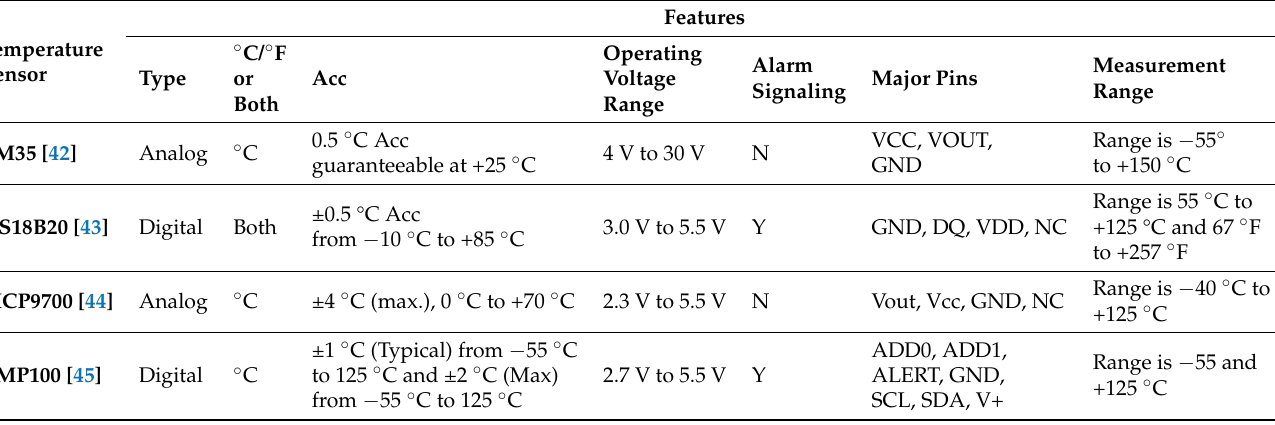
Table 6. Features of temperature sensors/devices.